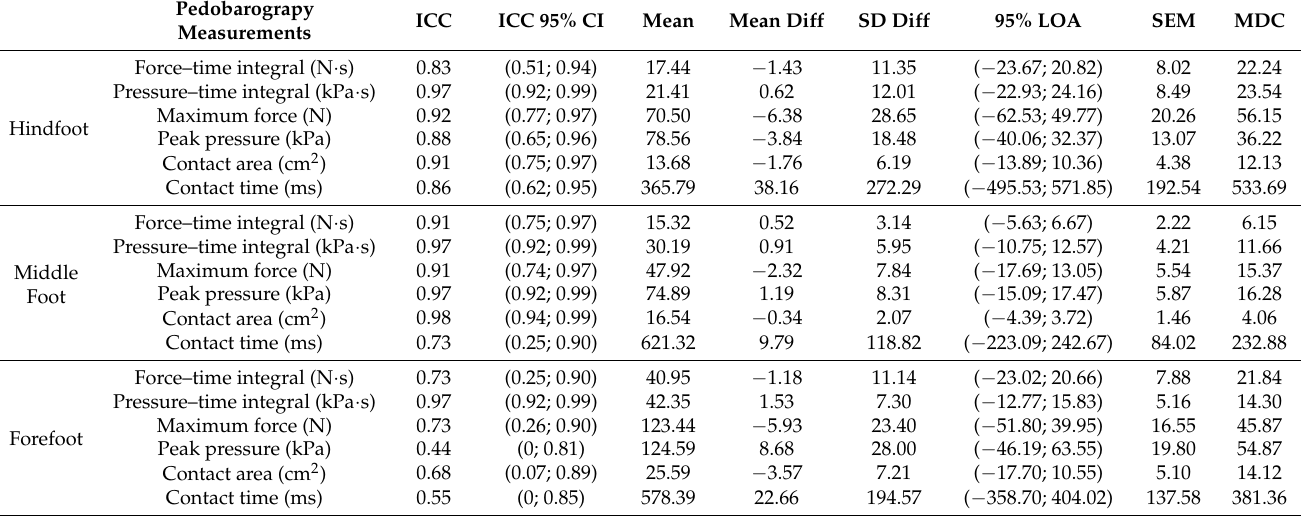
Table 3. Reliability values for pedobarography measurements (three zones of the segmented